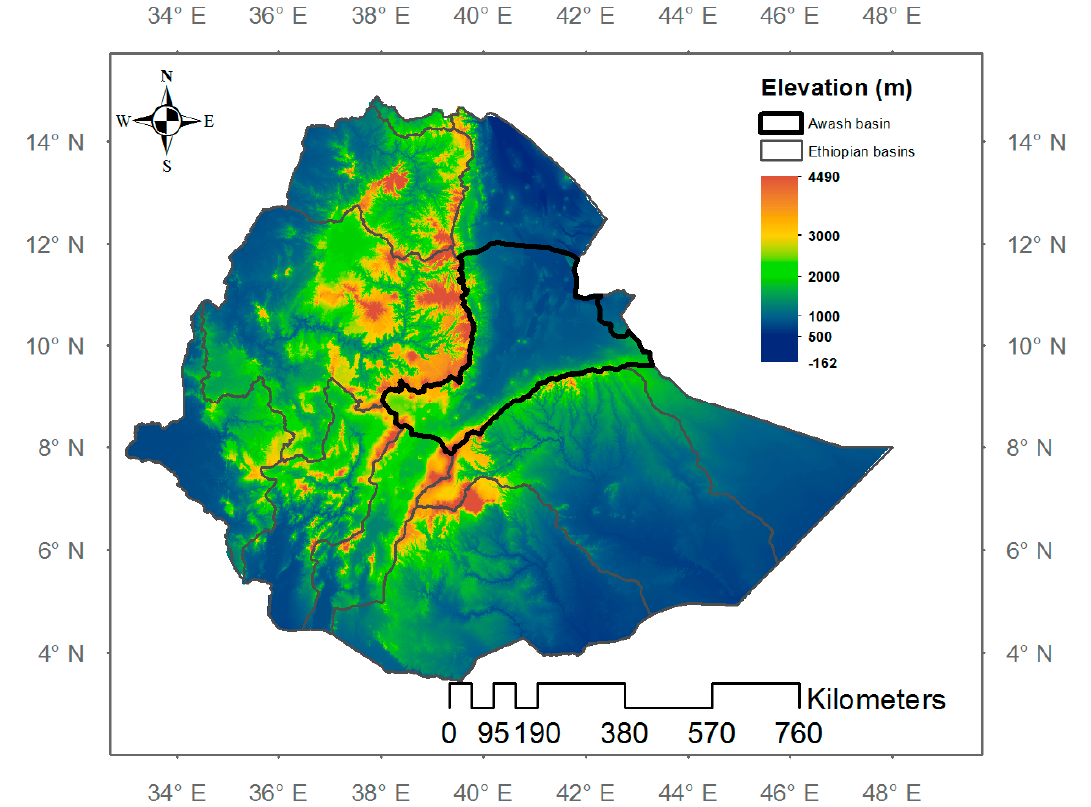
Figure 1. Location and elevation of Awash basin among the Ethiopian river basins.